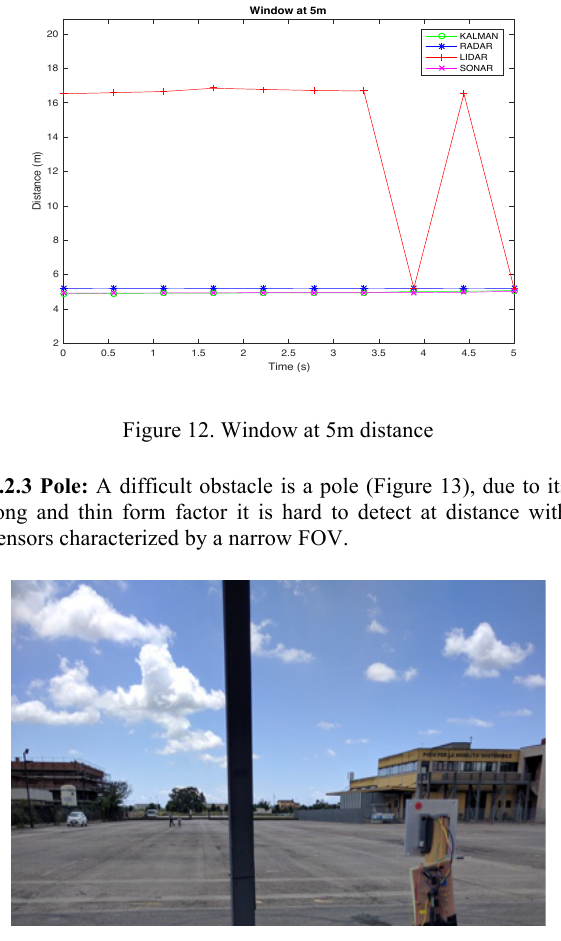
Figure 14 (b) is taken again at 5m, but slightly tilting the sensors